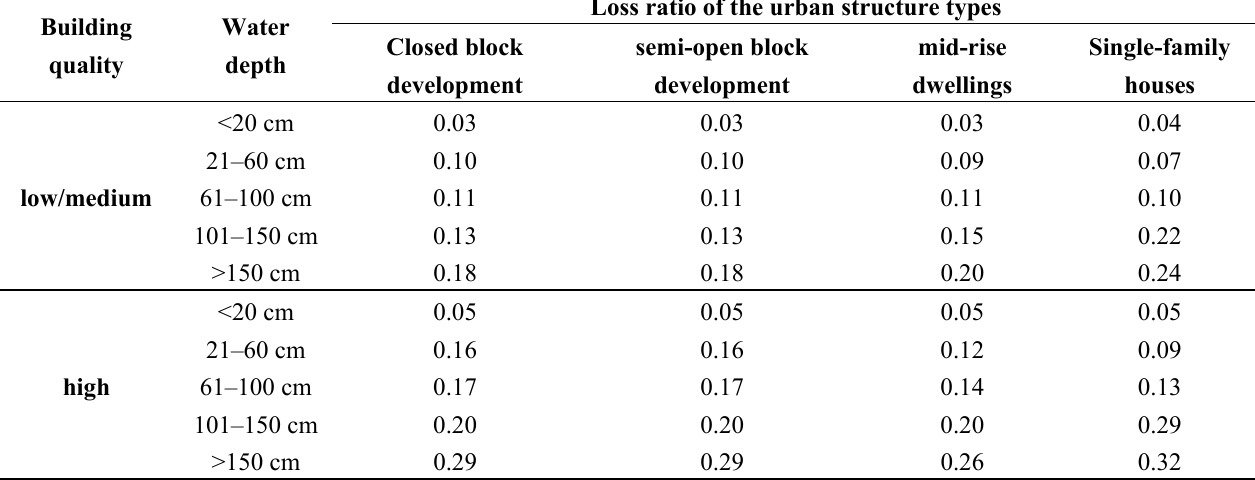
Table 5. Adapted FLEMOps model: loss ratios of the four urban structure types for two classes of building quality and five water